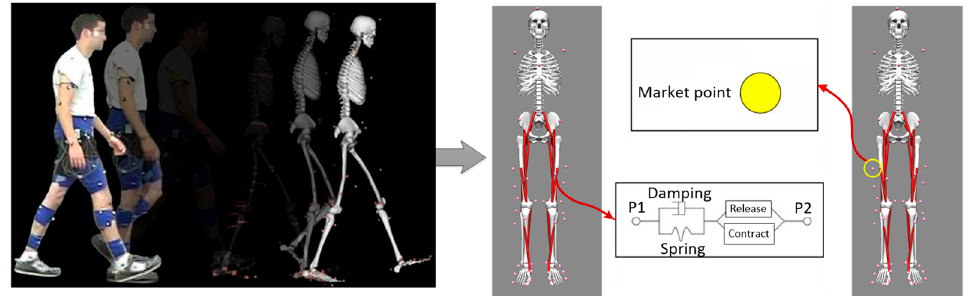
Figure 3. Simulation principle of muscle bone model.